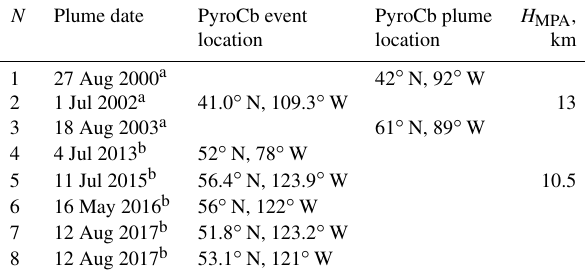
Table 2. List of documented pyroCbs, the plumes of which per- turbed the UTLS over Tomsk during the 2000–2017